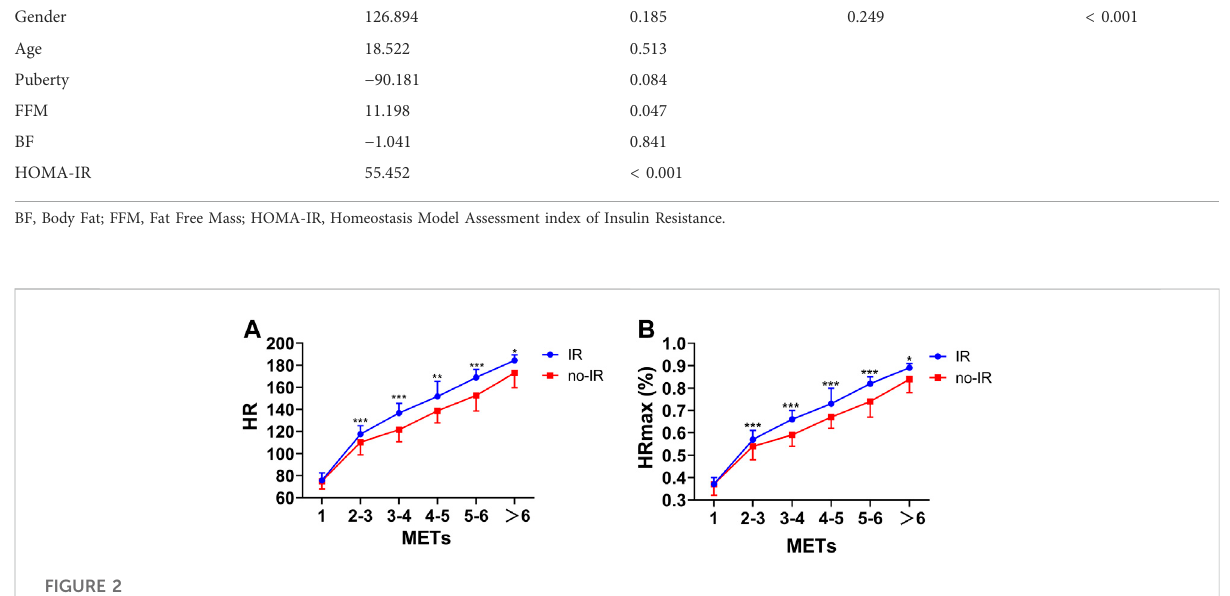
FIGURE 2 HRand HRmax (%)response totheincrementaltreadmilltestintheIR groupand no-IR group. Line graphfor theComparsion ofHRresponse in different METs. (A) : Comparsion of HR response to incremental treadmill test in the IR group and no-IR group; (B) : Comparsion of HRmax (%) response to incremental treadmill test in the IR group and no-IR group. * p < 0.05, ** p < 0.01, *** p < 0.001 between IR and no-IR